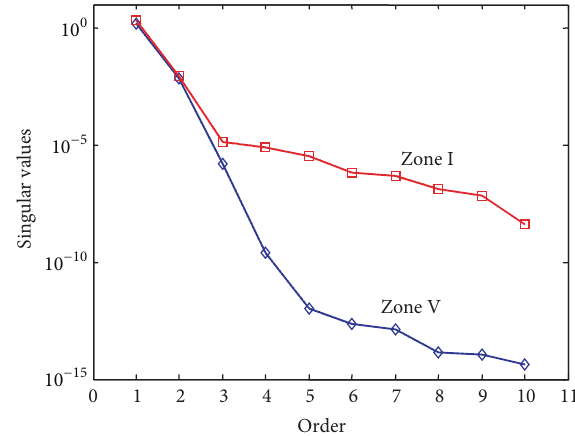
Figure 7: Singular values of zones I and V.